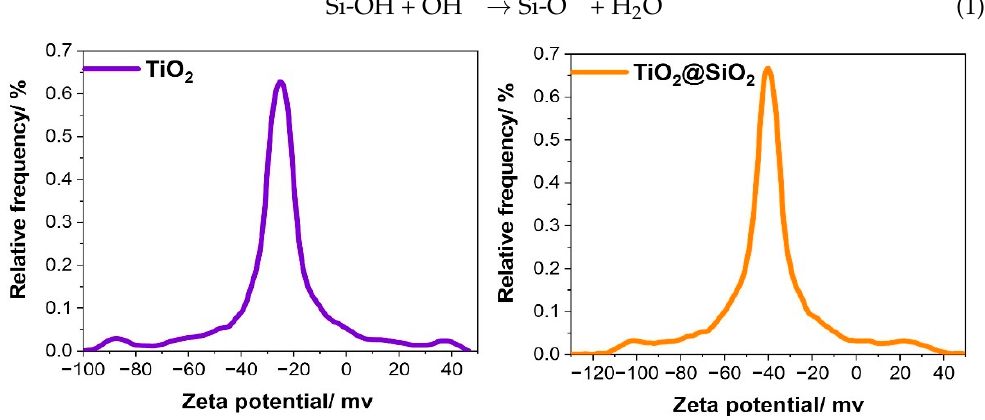
Figure 3. Diagrams of zeta potential for TiO 2 and TiO 2 @SiO 2 .